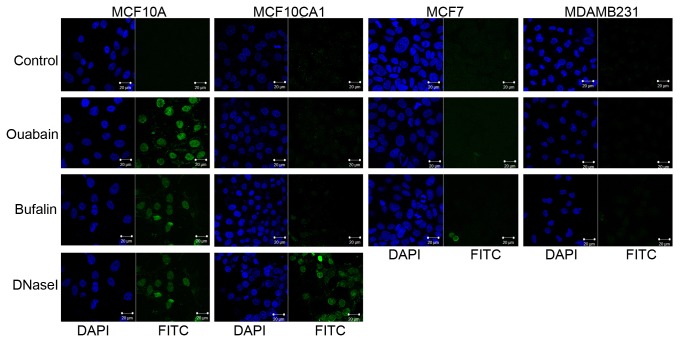
Apoptosis in normal and cancerous cells.Ouabain causes MCF10A cells to undergo apoptosis, but not MCF7, MDA-MB-231, or MCF10CA1 cells. DNA fragmentation (free 3’-OH ends) was visible by FITC (green) staining using the TUNEL assay when MCF10A cells were treated with 500 nM ouabain or 50 nM bufalin for 6 hours. DNaseI was included as a positive control for DNA fragmentation of in MCF10A and MCF10CA1 cells. DAPI (blue) was used to counter-stain the nucleus, and images were collected using Zeiss Confocal Microscope and Imaging Software.